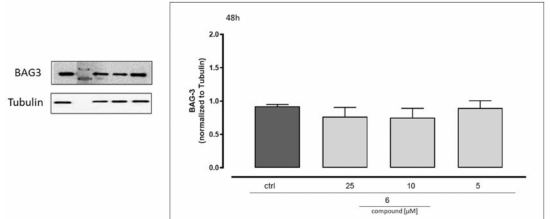
Figure 6. HeLa cells were treated with 6 (5-10-25 µ M) for 48 h. BAG3 expression was detected by Western blotting. Tubulin protein expression was used as a loading control. Results are expressed as mean ± S.E.M. from at least three independent experiments each performed in duplicate. Data were analyzed by Student’s t test vs.